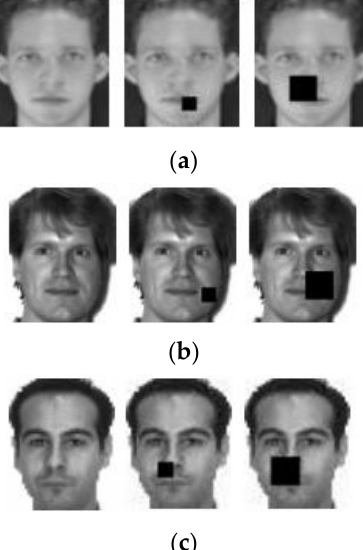
Figure 1. Partial original image and continuous occlusion image on ORL, YALE, and FERET database ( a ) ORL database ( b ) YALE database ( c ) FERET database.